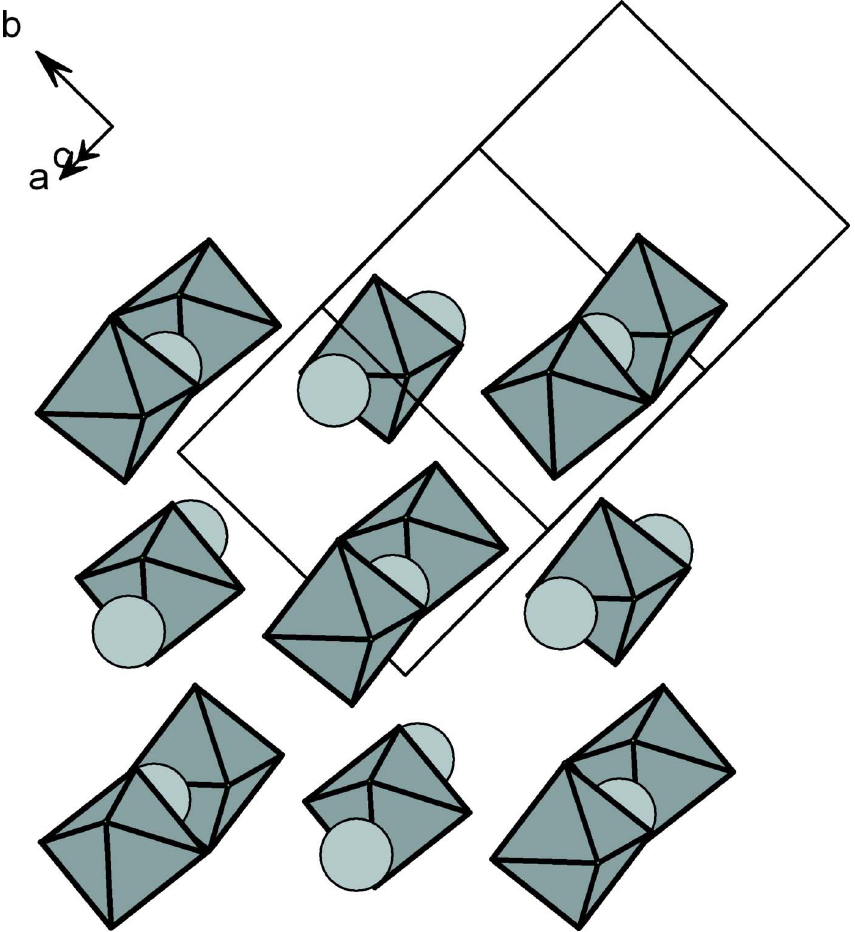
] 3- ions with triply charged virtual cations in the octahedral 6